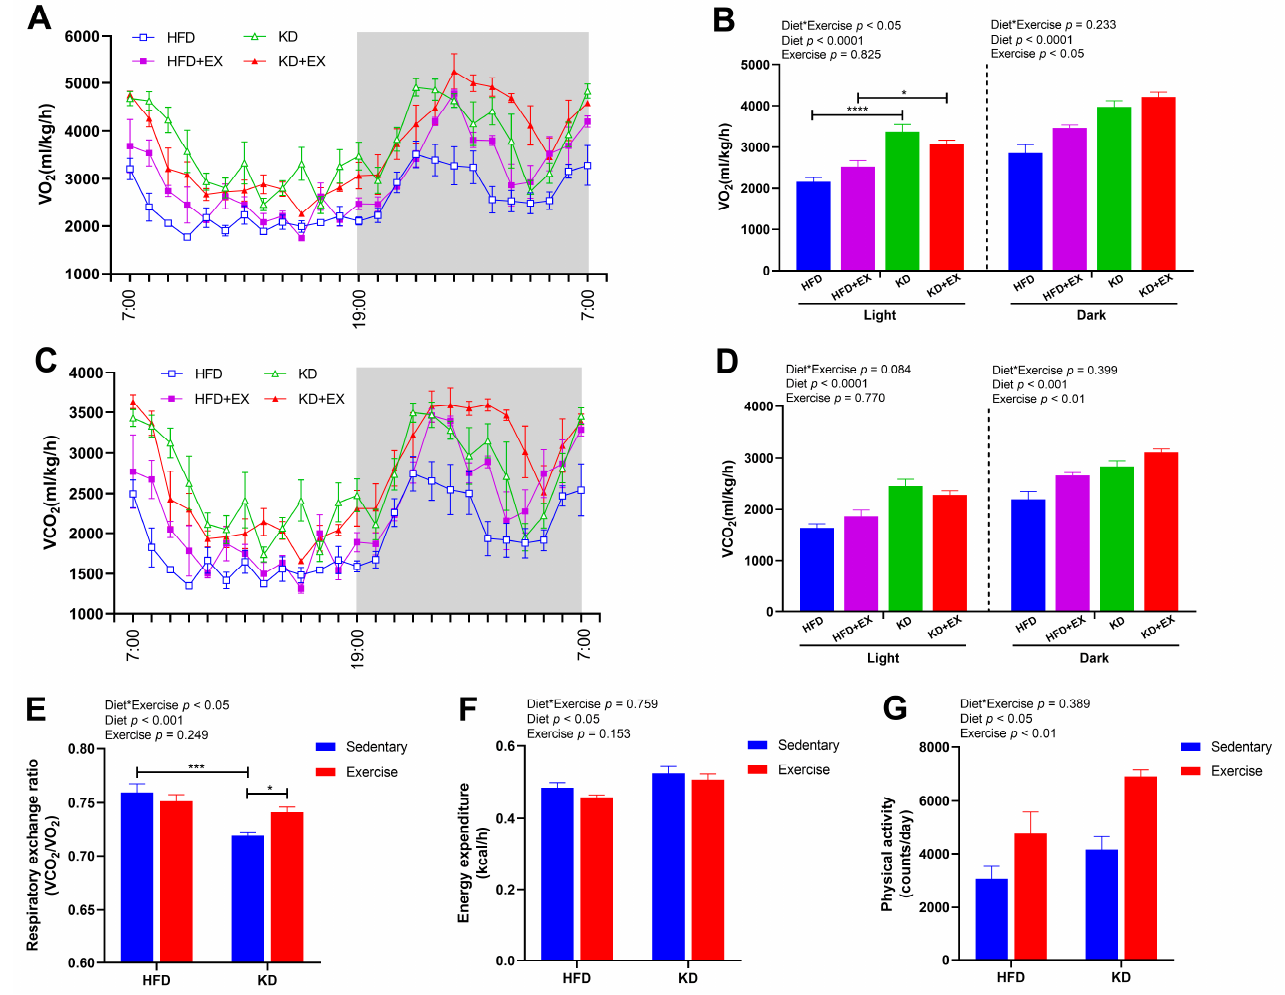
Figure 2. Energy metabolism in HFD, HFD + EX, KD, KD + EX groups of mice. ( A ) and ( B ) O 2 consumption (VO 2 ). ( C ) and ( D ) CO 2 production (VCO 2 ). ( E ) Respiratory exchange ratio (VCO 2 /VO 2 ). ( F ) Energy expenditure. ( G ) Physical activity. Values are given as mean ± SEM, n = 3–4. For panels ( B – F ), p values from the two-way ANOVA (i.e., main diet and exercise effects and diet*exercise interactions) are presented in the top left corner; Bonferroni post hoc test indicated significant differences (identified with an asterisk) at the following p values, * p < 0.05; *** p < 0.001; **** p <